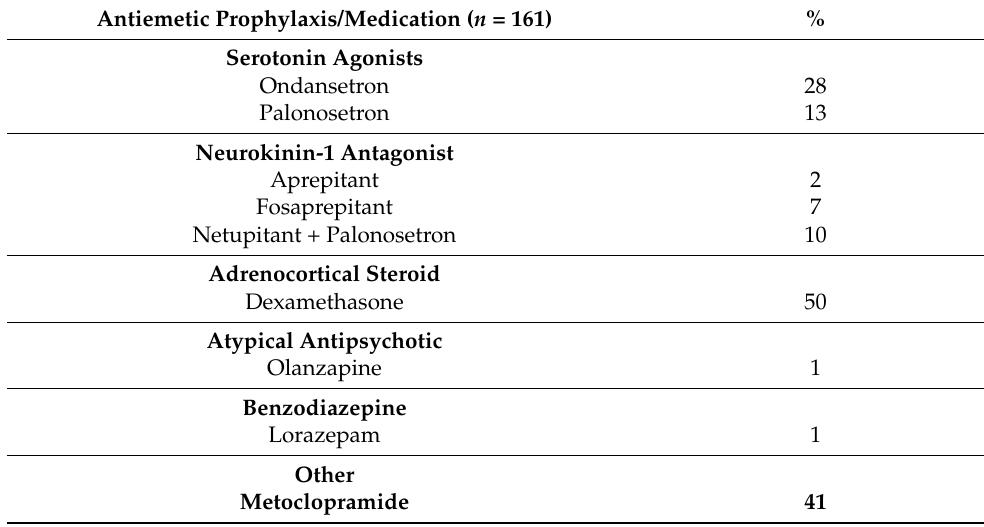
Table 3. Current antiemetic